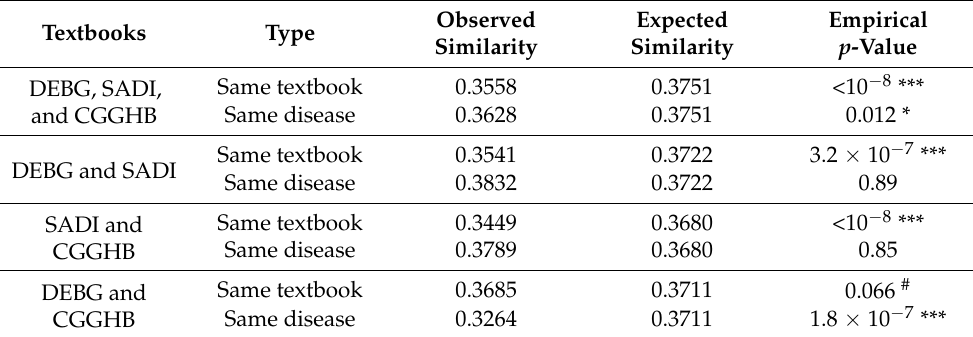
Table 1. Similarities between the AP-scores in the same textbook and the same disease. The Euclidean distance was used to determine the similarities: when the Euclidean distance between the AP-scores of documents was low, the similarity of the AP prescriptions was high. DEBG: Dongeuibogam , SADI: